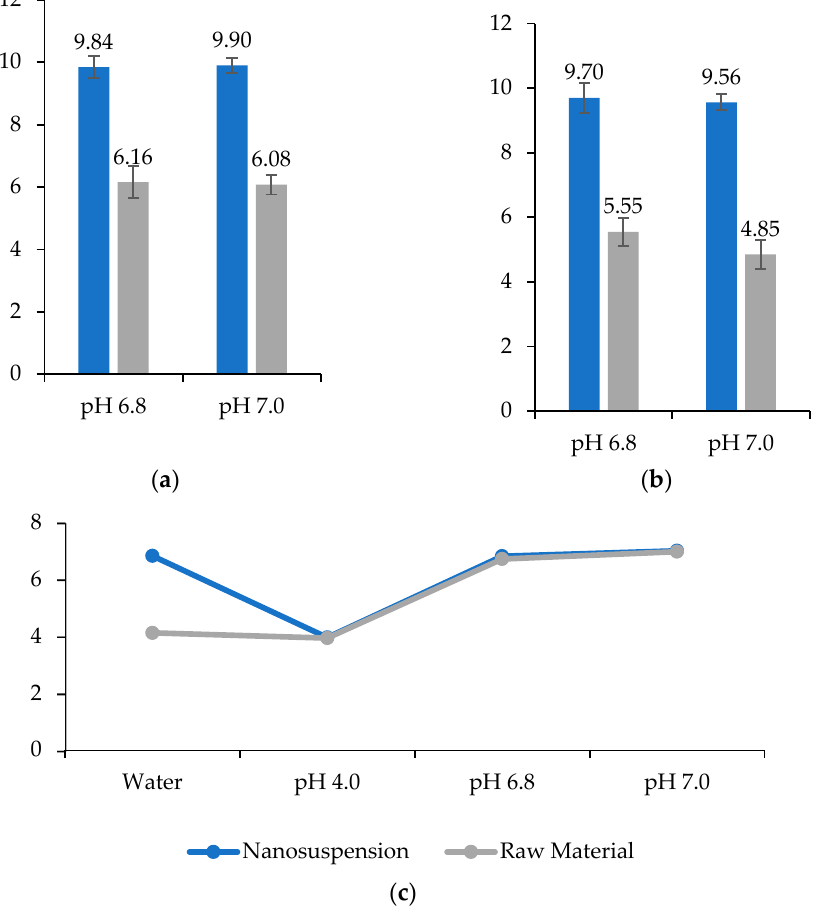
Figure 8. Saturation solubility of besifloxacin (raw material) and nanosuspension (besifloxacin 0.6 wt%). ( a ) Solubility after 24 h of incubation. ( b ) Solubility after 48 h of incubation. ( c ) pH of the samples at the end of the incubation. Theoretical concentration: 50 µ g/mL. n =